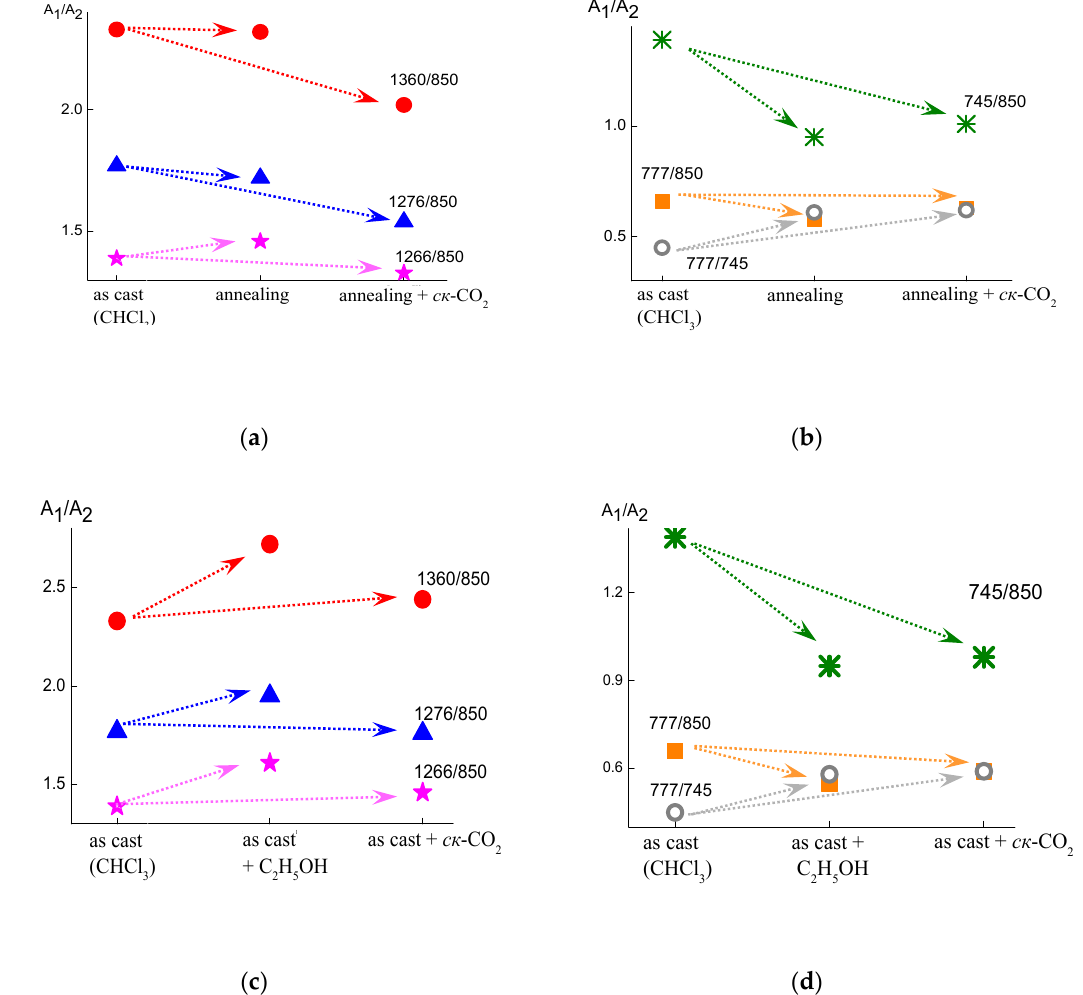
Figure 4. Changes in the relative intensities of the absorption bands of PI II functional groups ( a , c ): CO vibrations in benzimide and Ph–O–h (cid:48) groups; ( b , d )—vibrations in the Im–Ph–Im (cid:48) site) depending on the processing of its films: ( a , b )—as cast film, as-cast film after stepwise annealing, as-cast film after stepwise annealing and sc -CO 2 treatment; ( c , d )—as-cast film; as cast film after ethanol treatment; as-cast film after sc -CO 2